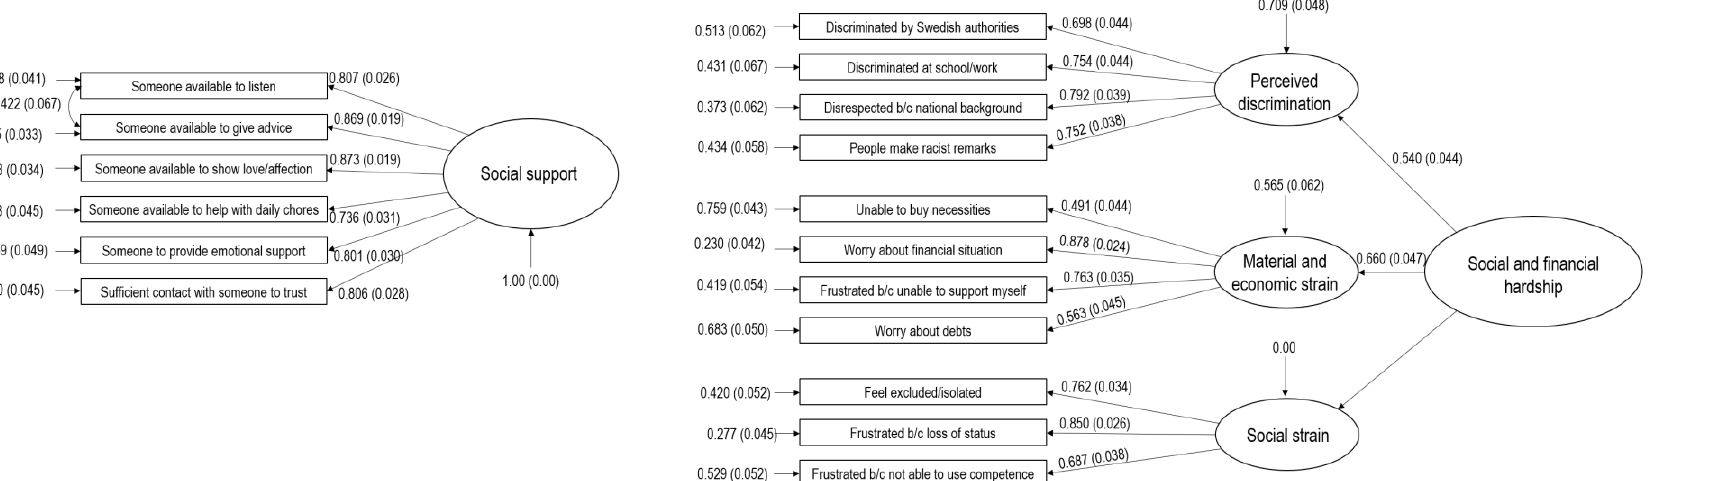
Figure 1. Measurement models in step one of Structural Equation Modeling procedure. Panel a shows final measurement model of social support; Panel b shows final measurement model for social and financial hardship. The displayed estimates are standardized coe ffi cients ( β ) and standard error is displayed in